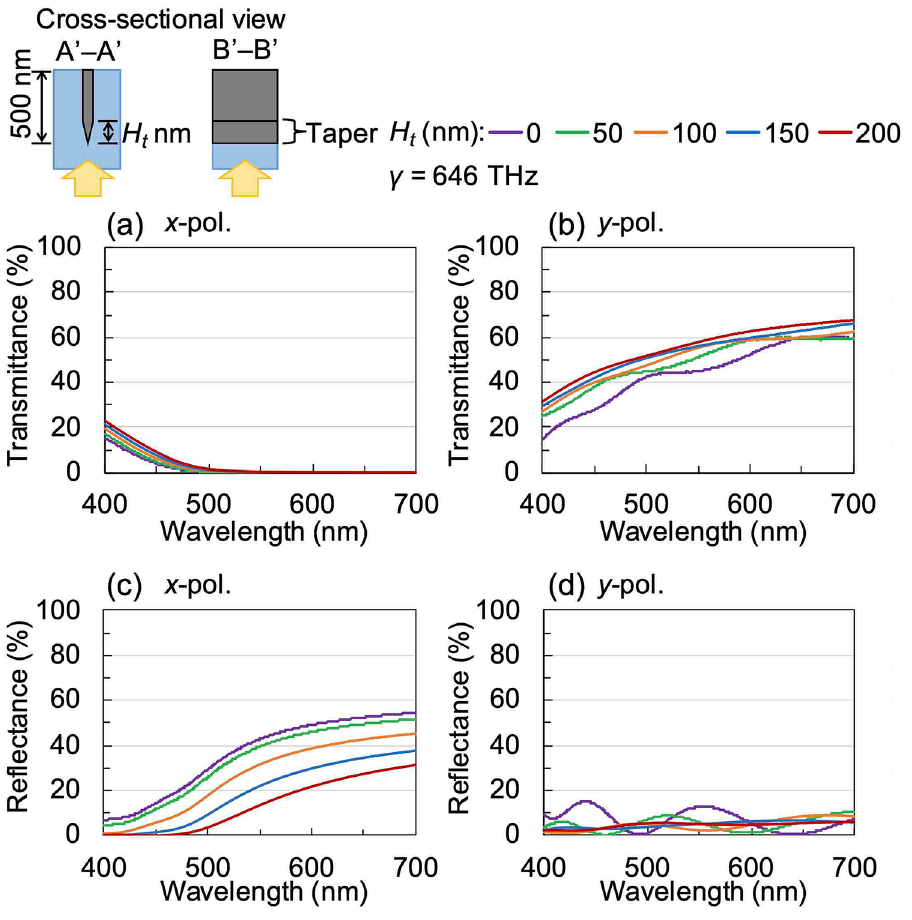
Figure 9. Calculated a , b transmittance and c , d reflectance spectra of embedded WGP sheet with a tapered tip as a function of H t . The polarisation directions are a , c x -polarisation and b , d y